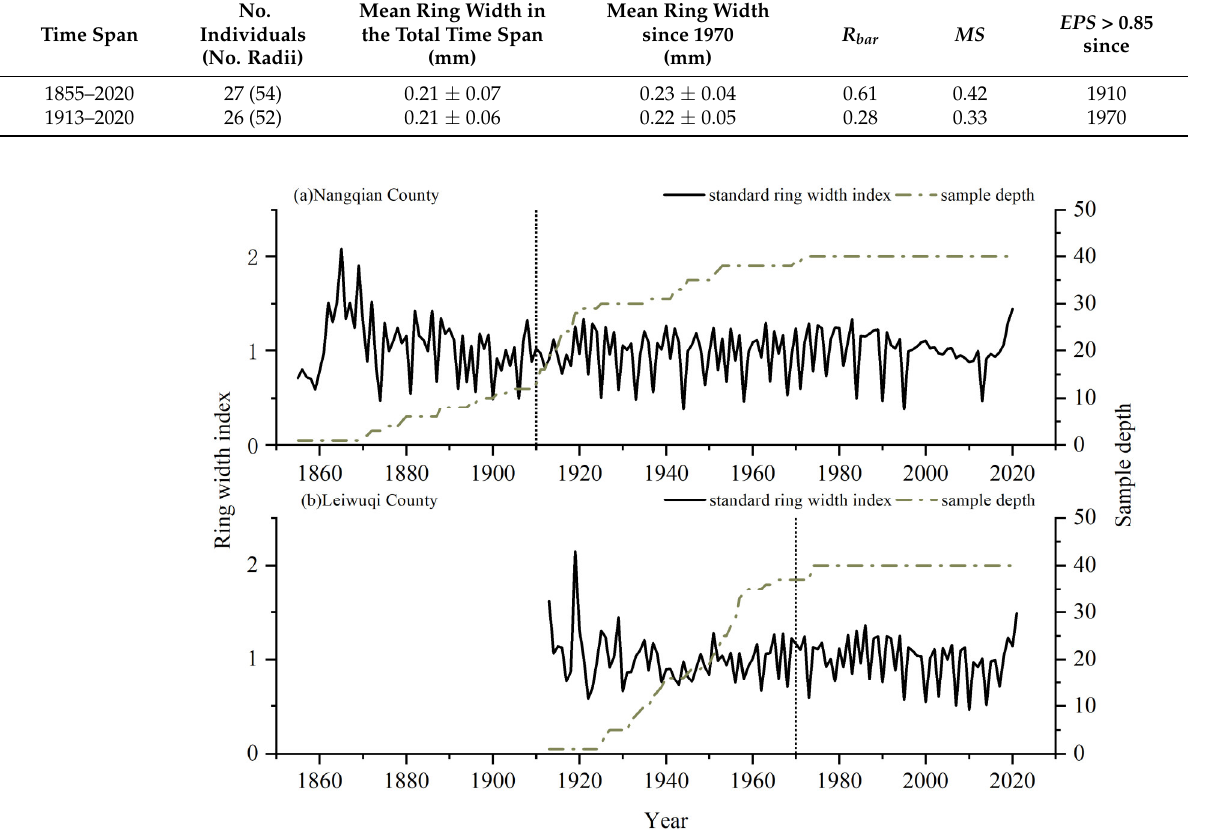
Table 1. Statistics of ring-width chronologies for the R. przewalskii shrub on the eastern TP. Abbre- viations: R bar (mean inter-series correlation), MS (mean sensitivity), EPS (expressed population signal).